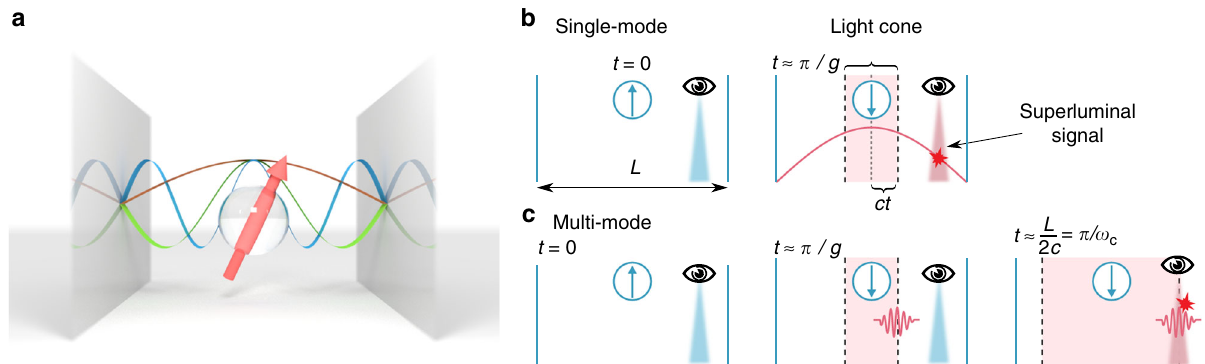
Fig. 1 The problem of superluminal signalling in the single-mode Rabi model. a Schematic view of a qubit embedded in a perfect 1D cavity, together with the depiction of the three lowest cavity modes. When the qubit is only coupled to the fundamental mode, the system is described by the Rabi Hamiltonian. b Violation of relativistic causality by the single-mode Rabi model in regimes where g ≈ ω c . An observer placed close to the cavity edge can retrieve information about the initial state of the TLS before light is able to reach its position. c A multi-mode description is able to capture the spatio-temporal structure of the light fi eld necessary to comply with